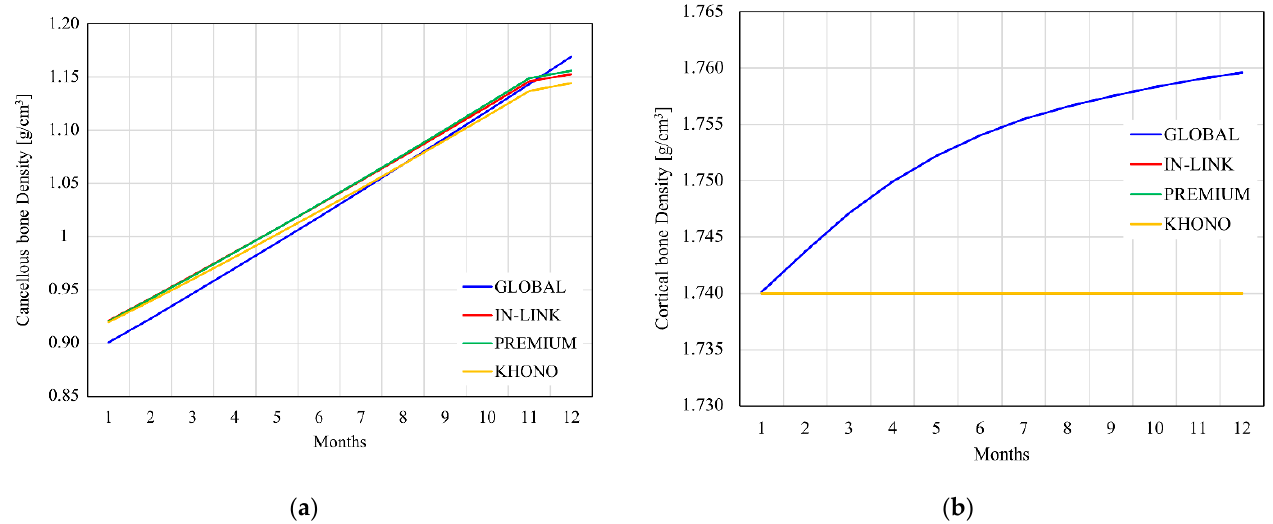
Figure 4. Density evolution of: ( a ) Cancellous bone; ( b ) Cortical bone.